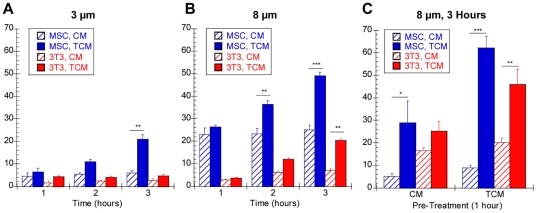
Effect of TCM on Cell Migration.Tranwell assays were used to measure the migration of MSCs and 3T3 fibroblasts through 3 µm- (A) and 8 µm- (B) pore transwell inserts toward CM or TCM. The average number of cells per image (n = 9), collected with a 10×-objective, was reported. TCM significantly increased MSC migration, compared to CM, through 3 µm pores within 3 hours and 8 µm pores within 2 hours; however, fibroblast migration was only increased through 8 µm pores within 3 hours. MSCs and 3T3 fibroblasts were then treated with CM or TCM for 1 hour and allowed to migrate through 8 µm-pore transwell inserts toward CM or TCM for 3 hours (C). Pre-treatment with TCM resulted in synergistic effects on chemotactic migration for both cell types.